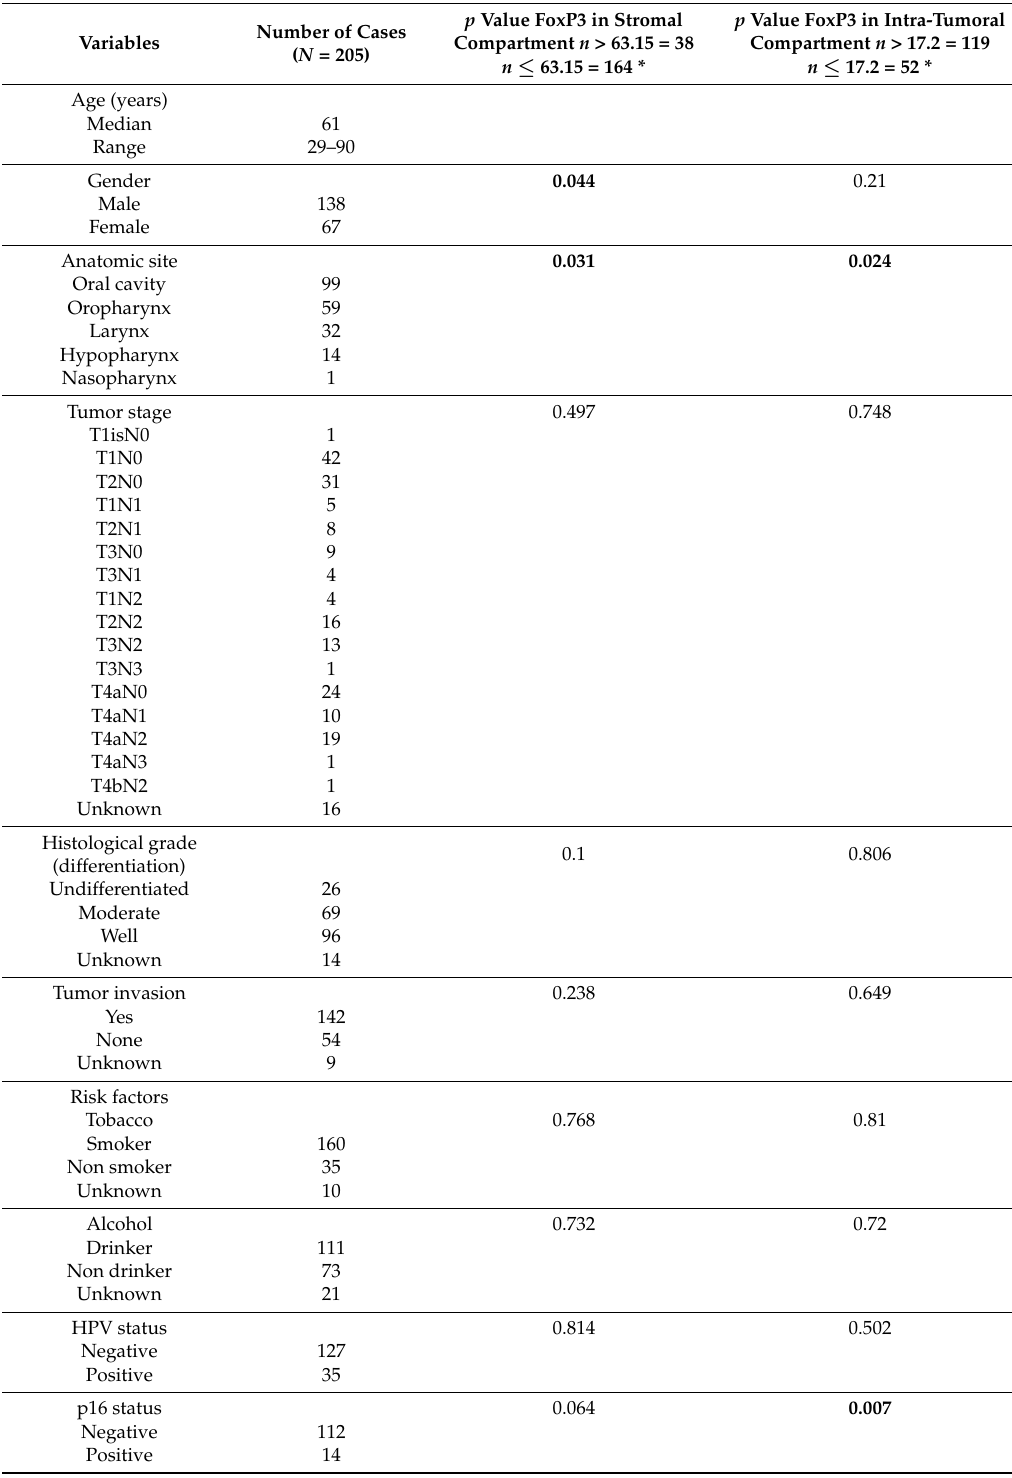
Table 1. Characteristics of patient population used in this study. p values < 0.05 are highlighted in bold.